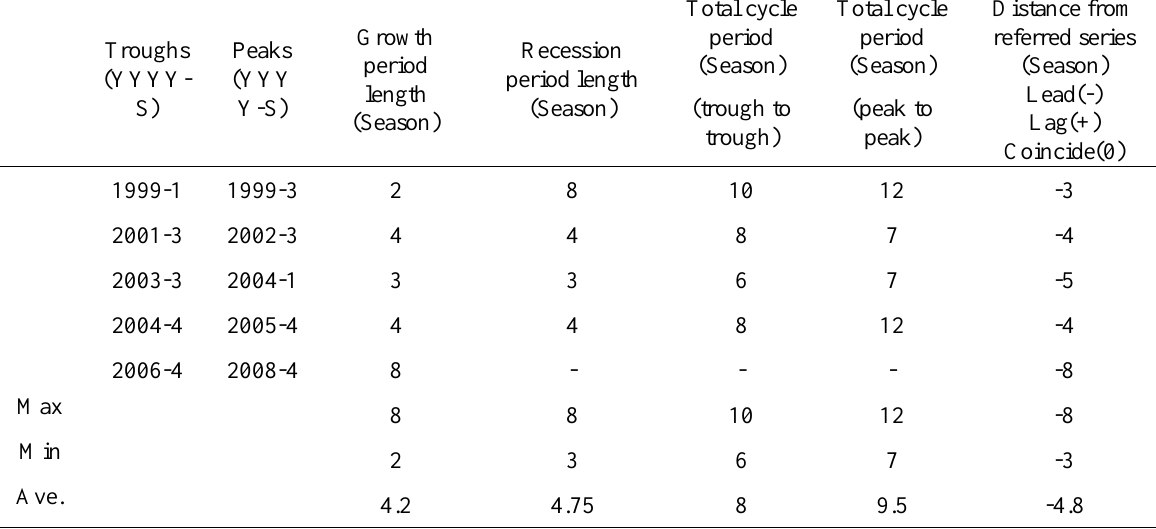
Table 5. Turning points of industrial production index and its comparison with reference series Troughs